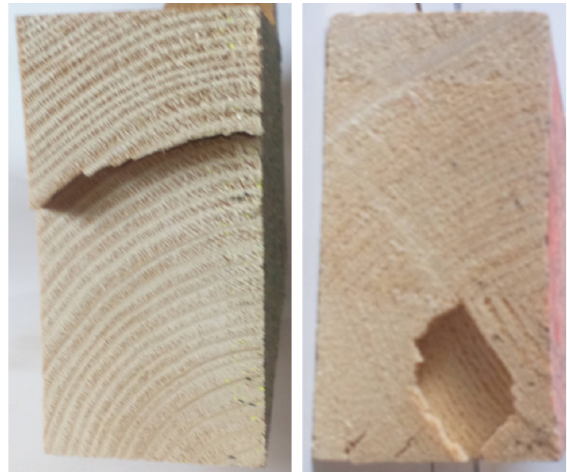
Figure 11. The end of the beam #08 (left) and #09 (right) demonstrating the shear failure.